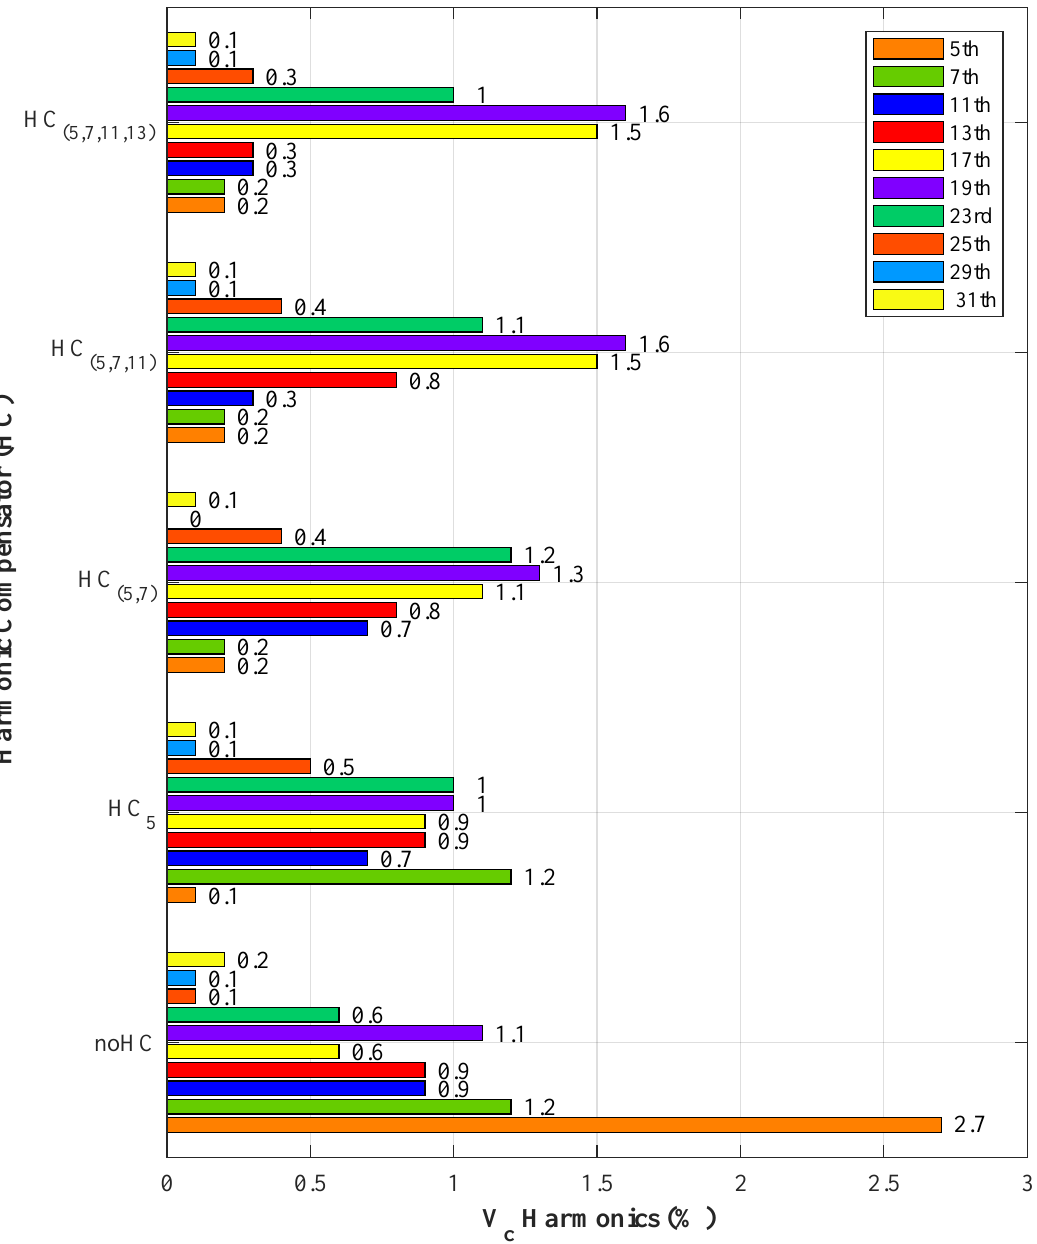
Figure 23. Harmonic V c content controlled by OPAL-RT OP5700